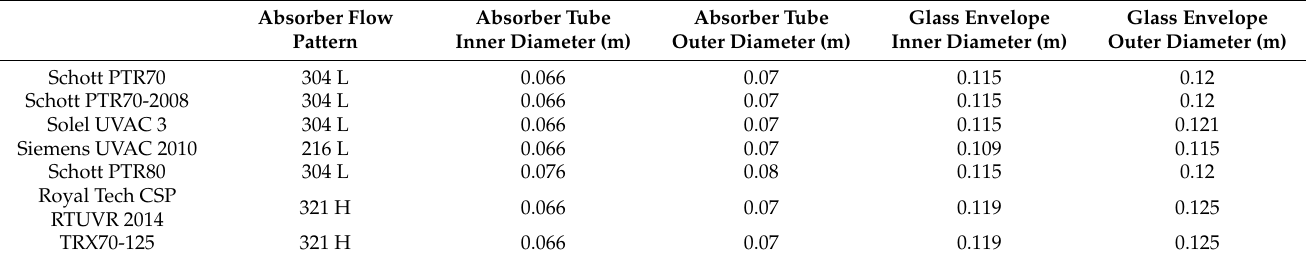
Table 2. Description of different parabolic trough solar receiver HCEs available on the market.